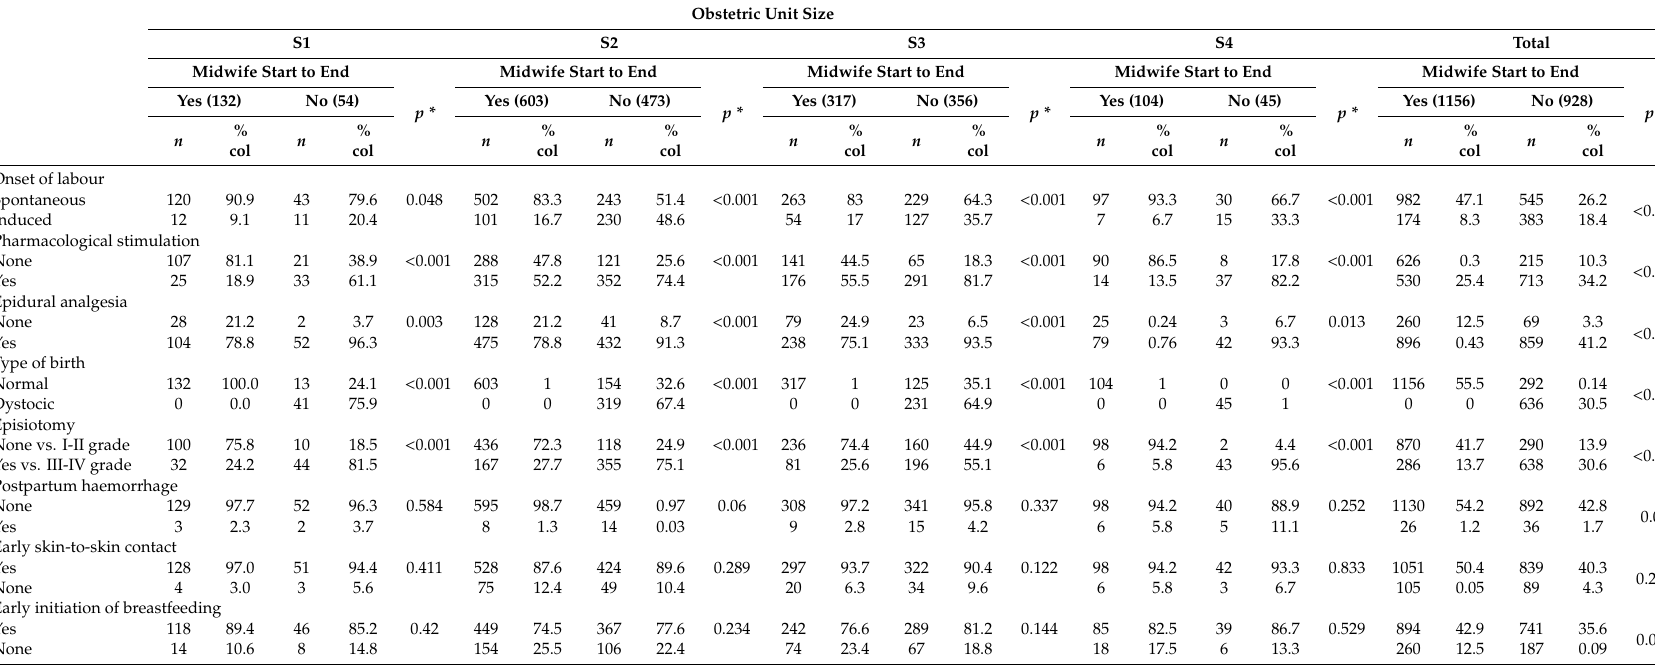
Table 2. Transfer of care distribution between di ff erent studied variables, and Odds Ratio and 95% confidence intervals ( N =